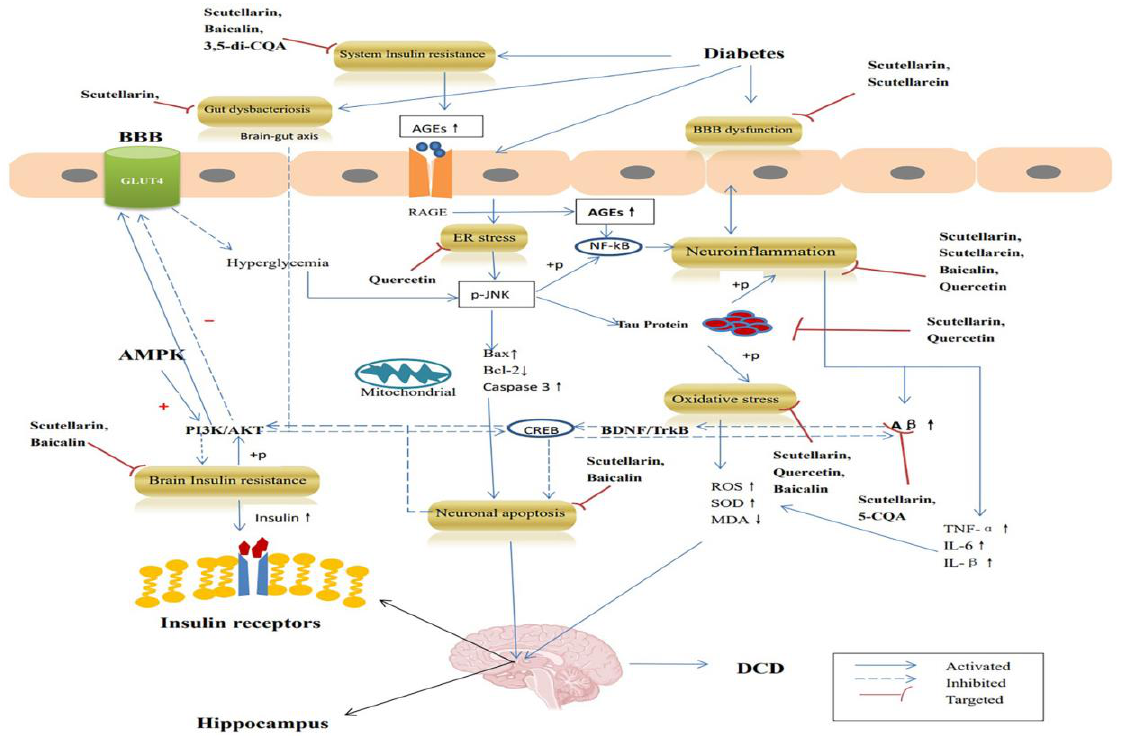
Figure 2. The anti-DCD mechanism of EBHM’s active component. Baicalin may decrease adenylate-activated protein kinase levels, increase glucose absorption and glycolysis, and block hepatocyte gluconeogenesis via activating the AMPK- mediated PI3K/AKT pathway [59], which reduces adenylate-activated protein kinase levels and reduces insulin resistance [44]. Additionally, research has shown that baicalin’s metabolites have the same mechanism owing to the poor oral utilization rate of the drug [59]. Moreover, 3, 5-di-CQA has -glucosidase inhibitory activity, which can reduce intestinal glucose absorption and regulate postprandial hyperglycemia